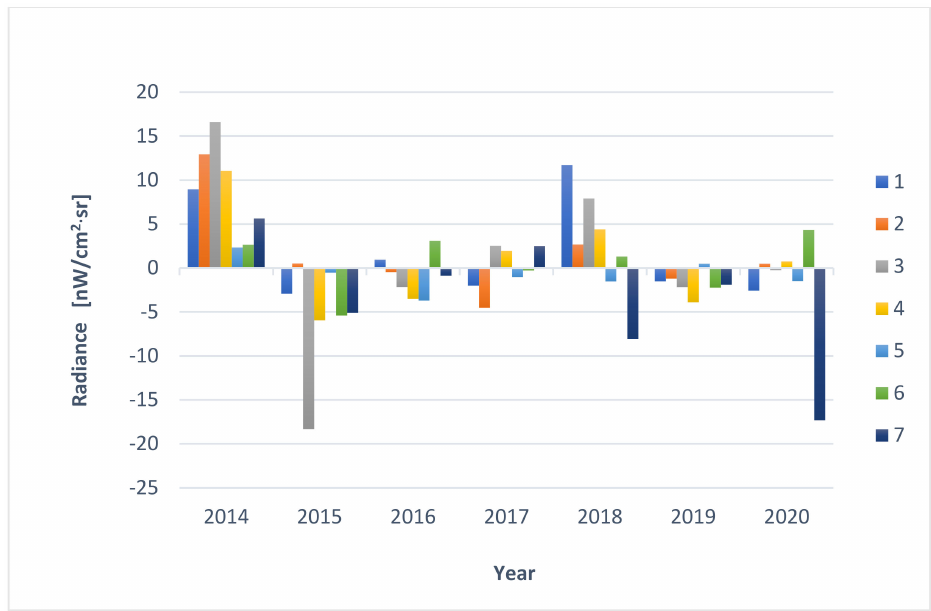
Figure 12. Differences in radiance values in 2014–2020 determined by two services. Source: authors’ elaboration. Table 4. Comparison of data from two services—absolute values of differences (unit nW/cm 2 · sr). Source: authors’ elaboration. Year Value Differences in Point Point